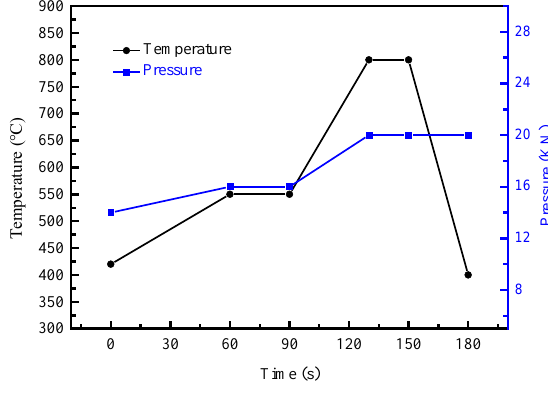
Figure 2. Sintering process of powders .